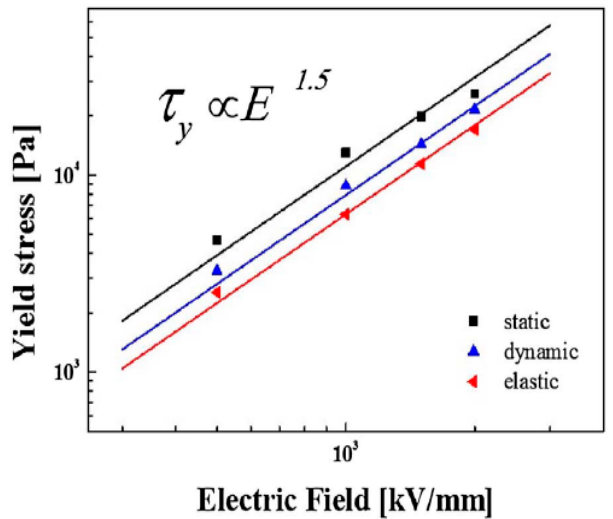
Figure 12. Static, dynamic, and elastic yield stresses as a function of electrical field strength for PANI-nanotube-based ER suspension, reprinted with permission from [119]. Copyright Elsevier, 2017.